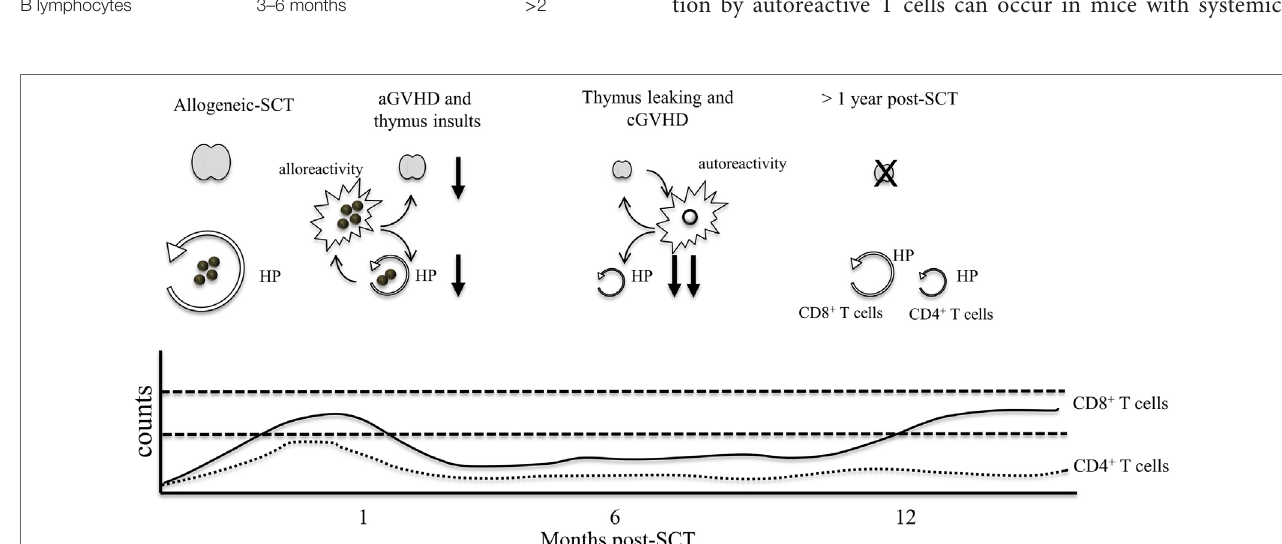
FiGURe 2 | The effect of GVHD on lymphocyte numbers. Following chemotherapy, thymic insults induce thymic involution and loss of thymic output. Early after T cell infusion, CD4 + and CD8 + T cell counts increase as a consequence of HP and alloreactive T cell activation. At 1 month post-allogeneic-SCT, GVHD T cells induce damage to the thymus and the peripheral niche, resulting in severe thymic dysfunction and lower HP of T cells. During this period, patients are profoundly lymphopenic. After several months, the thymus may leak few autoreactive T cells, which contribute to the development of cGVHD. Autoreactive T cells can further damage the thymus and the peripheral niche, resulting in long lasting immunosuppression. At 1 year post-GVHD, rises in CD8 counts can occur through HP whereas HP of CD4 + T cells remains highly inefficient resulting in chronic CD4 lymphopenia that can persist for several